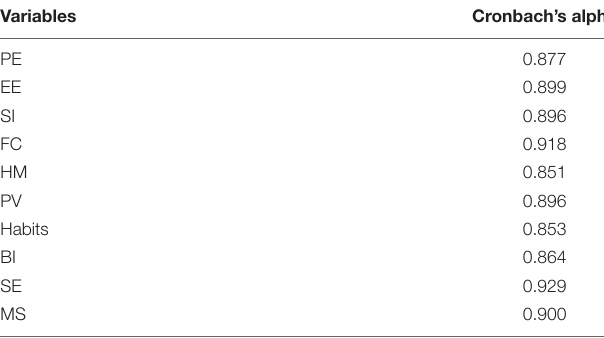
TABLE 2 | Reliability statistics.